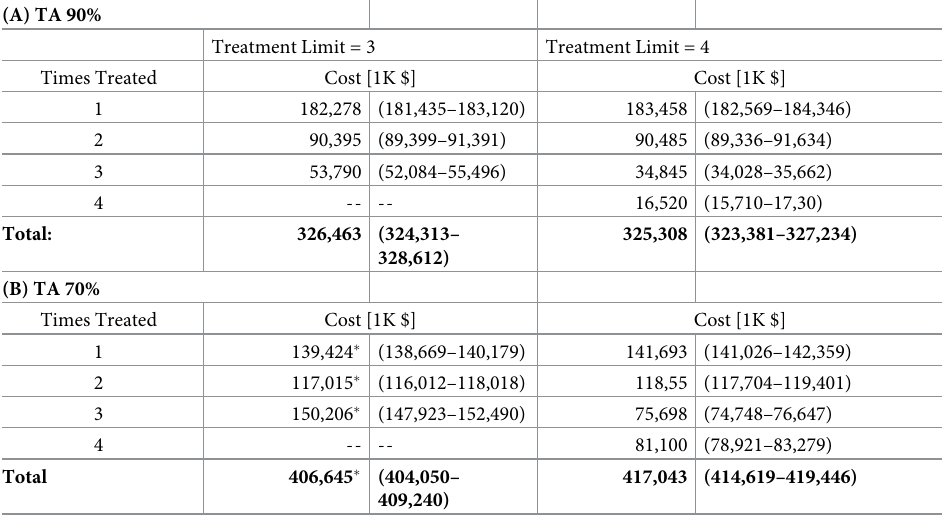
Table 4. Mean treatment costs (95% CI) for DAA treatment rate of 7.5% per year with 1–3 (Treatment Limit = 3) or 1–4 (Treatment Limit = 4) DAA courses permitted, and treatment adherence (TA) of 90% (A) and 70% (B). Cost values are rounded to the nearest 1K$. The DAA cost per treatment is $25,000. The related number of treatments is shown in Table 3 Treatment costs for each group (times retreated) is calculated as the number treated in each group multiplied by the number of times treated multiplied by the cost per treatment. Entries marked with ( � ) indicates sce- nario does not achieve WHO incidence elimination